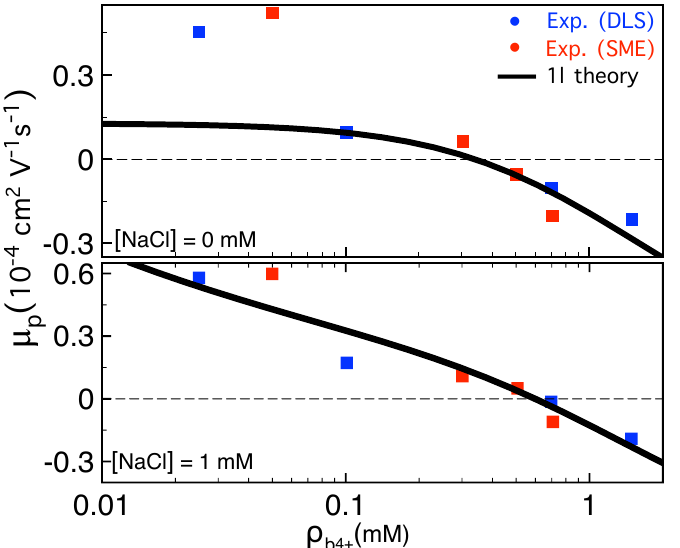
Figure 4. Electrophoretic DNA mobility µ p = v dr / E against Spm 4 + concentration in the electrolyte mixture NaCl + SpmCl . The monovalent cation density is ρ b + = 0 mM ( top ) and 1 mM ( bottom ). 4 Solid curves: Theoretical prediction of Equation (18) at the electrostatic one-loop (1l) level. Symbols: Dynamic light scattering (DLS) and single molecule electrophoresis (SME) data of Ref. [30]. ds-DNA molecule has radius a = 1 nm and effective surface charge density σ p = − 0.12 e/nm 2 . The nanopore has radius d = 10 nm and fixed surface charge density σ m = − 0.006 e/nm 2 . The results are from Ref.